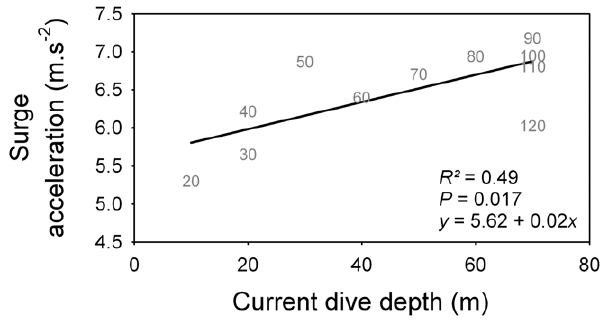
Figure 3. Relationship between peak in surge acceleration for different maximum dive depth categories and current dive depth. For positioning of peaks, see Fig. 2. Each data point is symbolized by a number representing maximum dive depth category. The deepest category (120–130 m) was excluded from the regression (see Fig. 2).